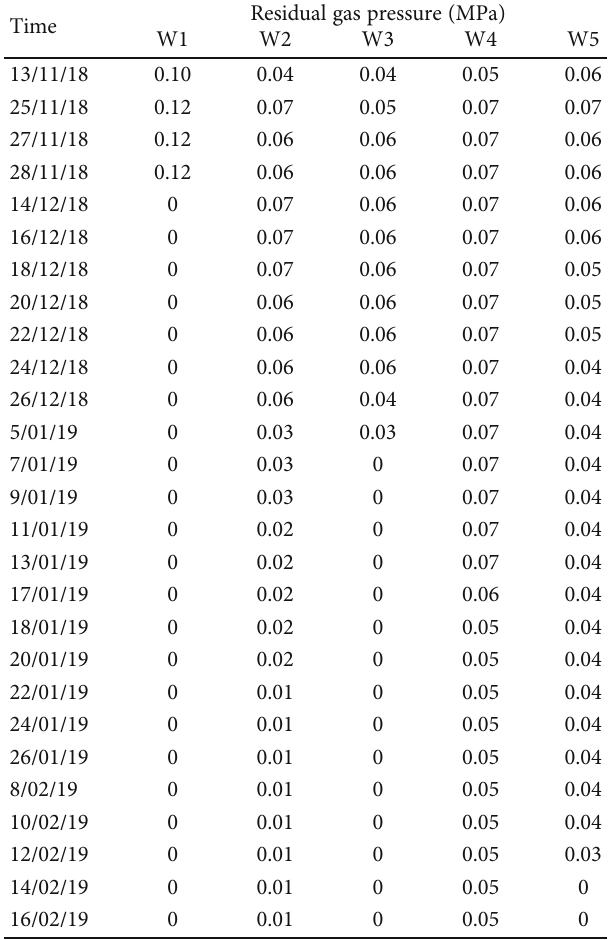
Table 10: Monitoring results of residual gas